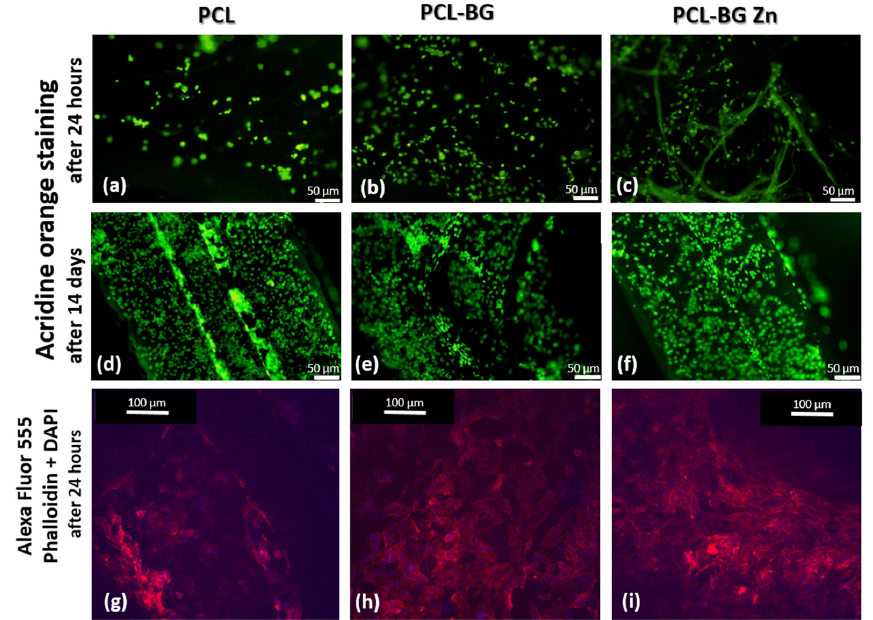
Figure 10. Acridine orange (green color indicates the viable cells) staining, (a) cells cultivated 24 hours on PCL samples, (b) cells cultivated 24 hours on PCL-BG, (c) cells cultivated 24 hours on PCL-BG Zn, (d) cells cultivated 14 days on PCL samples, (e) cells cultivated 14 days on PCL-BG, (f) cells cultivated 14 days on PCL-BG Zn Alexa Fluor ® 555 Phalloidin (red color indicates the cytoskeleton), and DAPI (blue color indicates the nucleus) staining (g) cells cultivated 24 hours on PCL samples, (h) cells cultivated 24 hours on PCL-BG samples, (i) cells cultivated 24 hours on PCL-BG Zn samples.